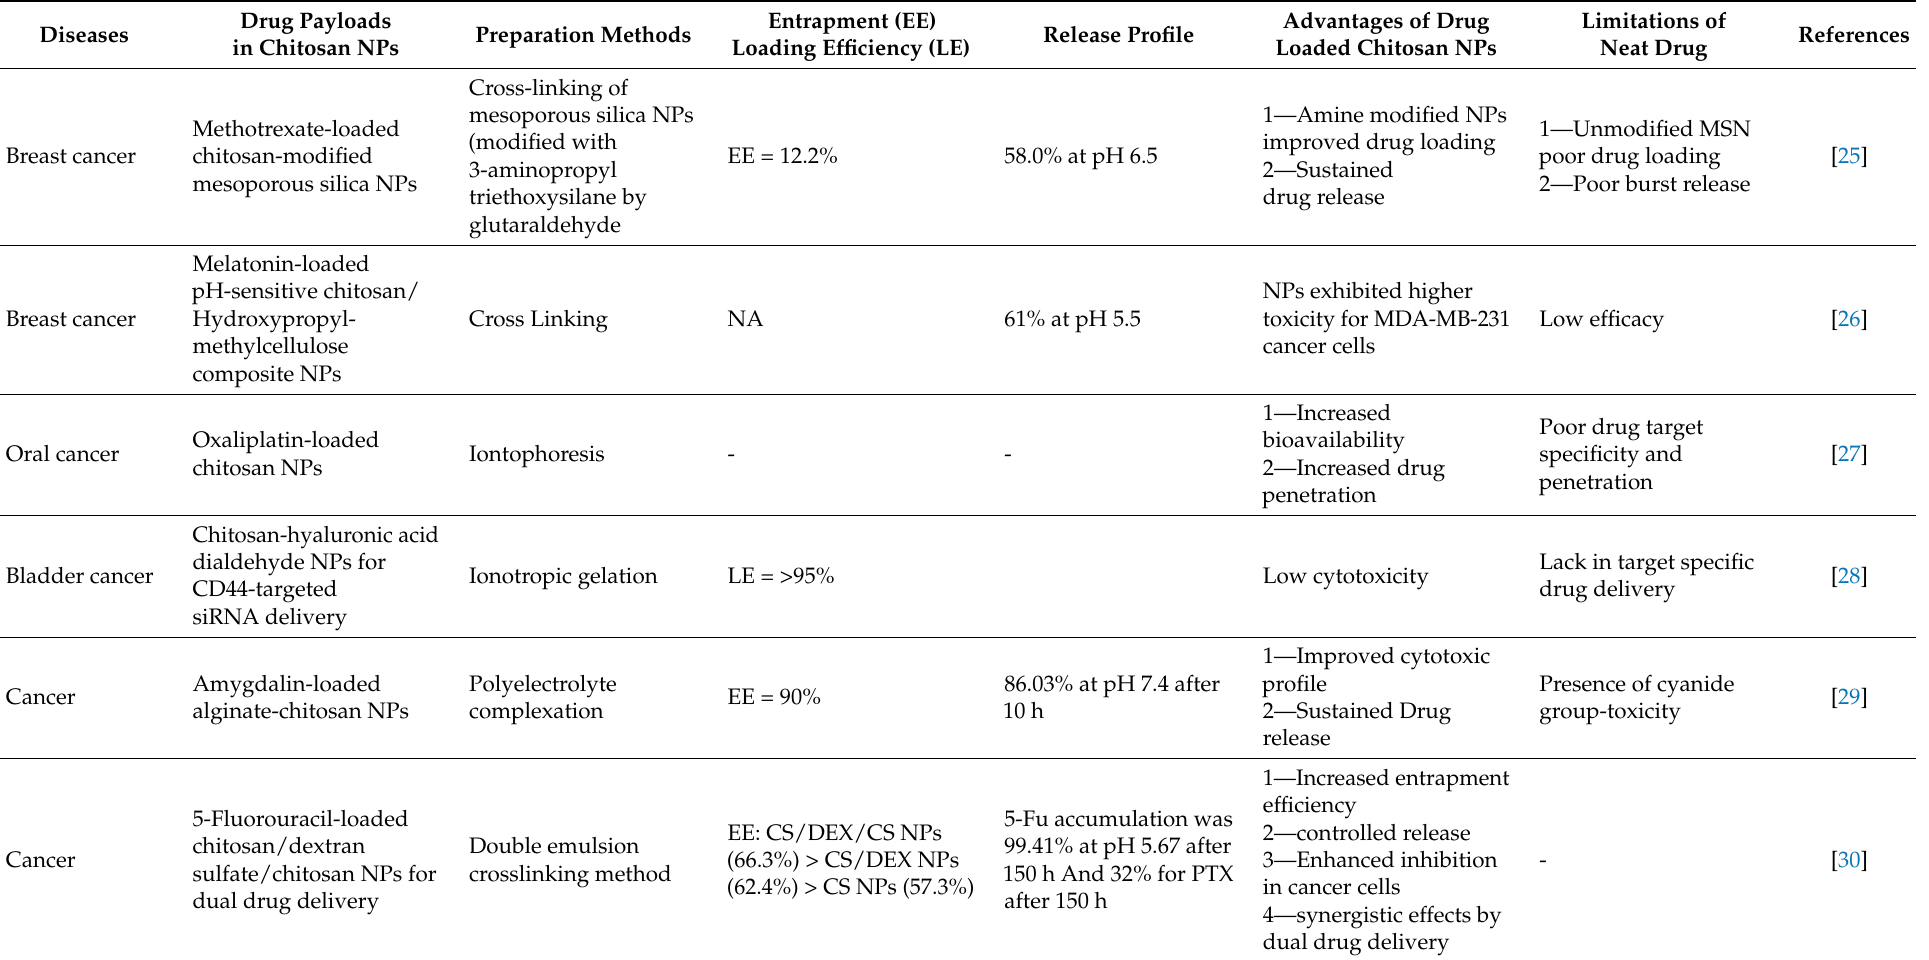
Table 1. Chitosan NPs- drug payloads, preparation, entrapment efficiency,